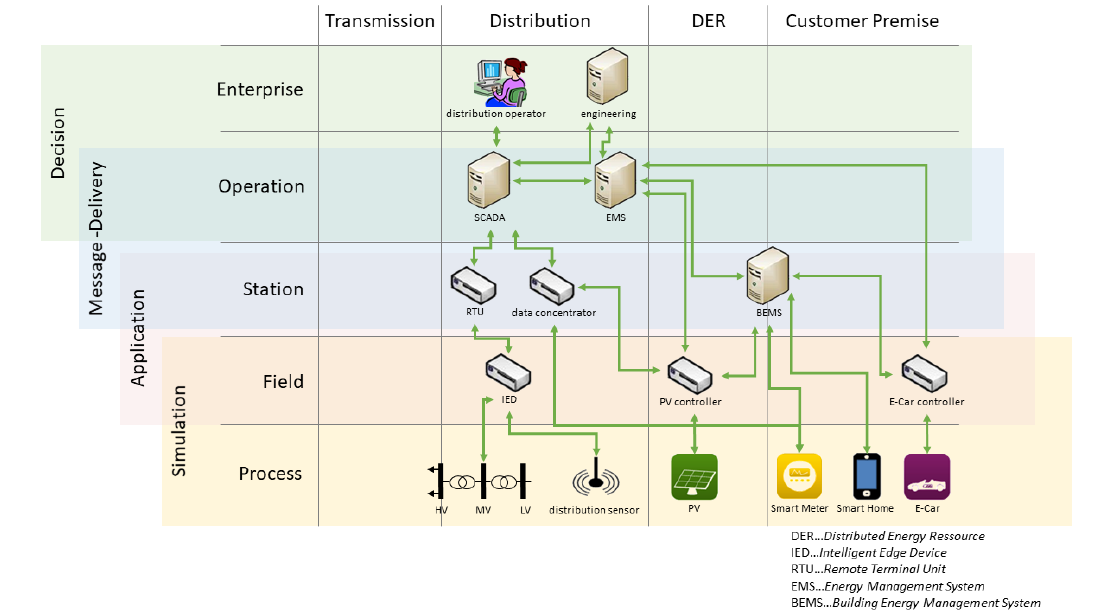
Figure 3. Mapping to